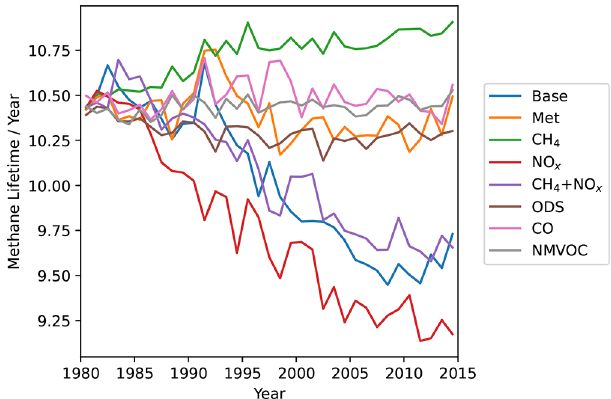
Figure 13. CH 4 lifetime with respect to oxidation by OH for the different model runs. CH 4 lifetime is calculated via the global an- nual mean atmospheric CH 4 burden divided by annual mean CH 4 tropospheric chemical loss by OH. CH 4 lifetime has decreased in the Base run even as CH 4 concentrations have increased driven by [OH]